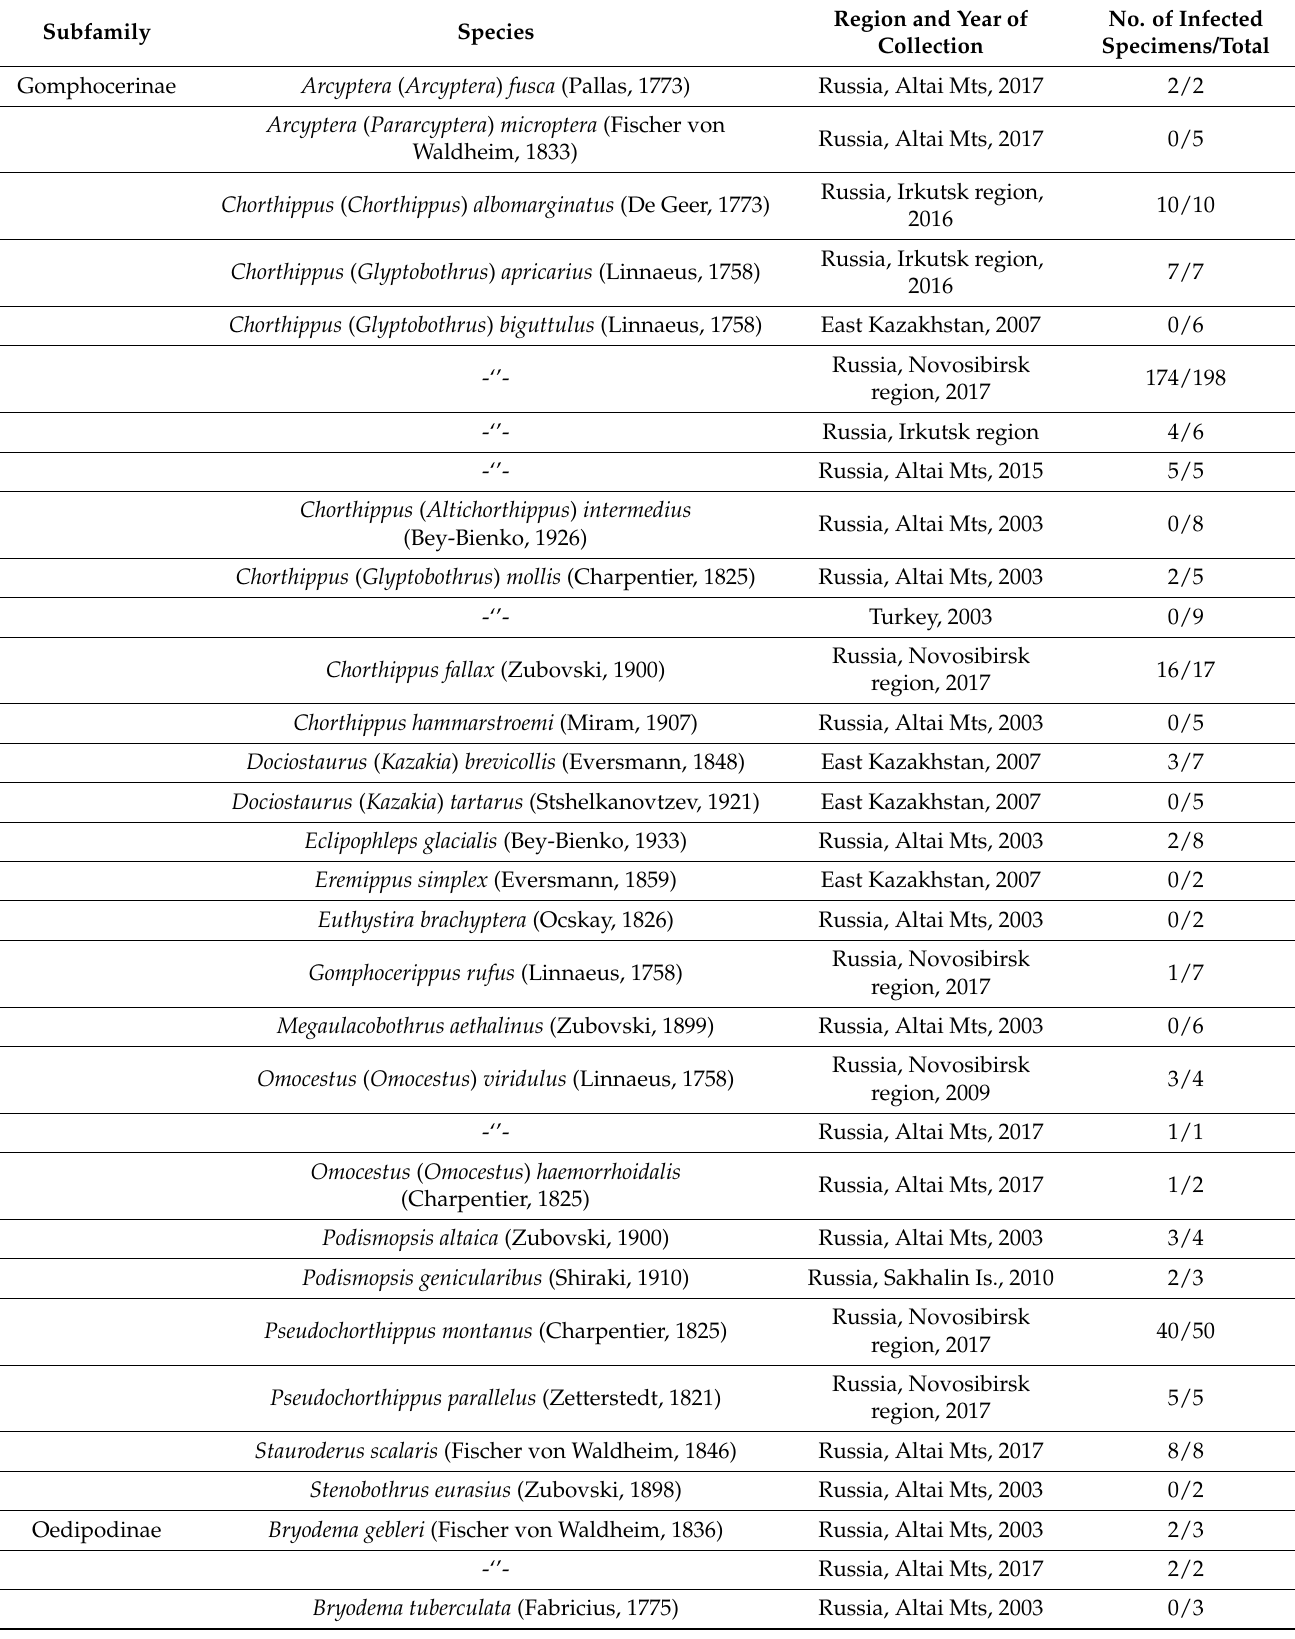
Table 1. The Acrididae specimens and Wolbachia